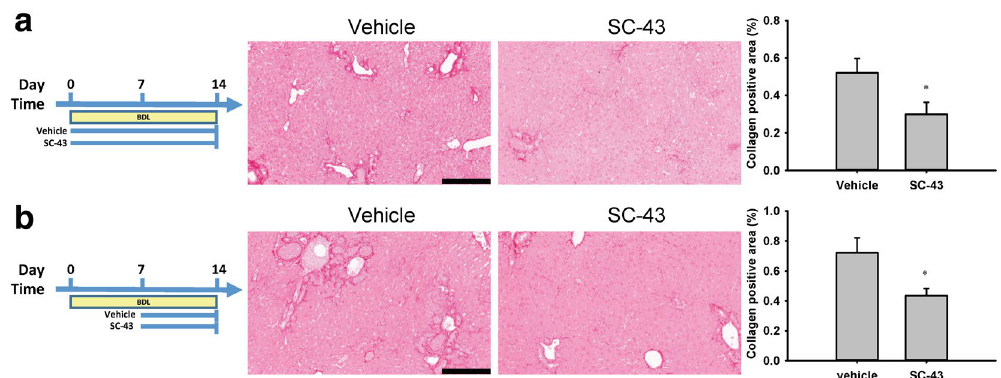
Figure 4. SC-43 treatment ameliorates liver fibrosis in the bile duct ligation liver fibrosis mouse model. In the BDL fibrosis prevention model, the vehicle and SC-43 (10 mg/kg) were administered from day 1 until sacrifice on day 14 of BDL. SC-43 treatment yielded significant fibrosis regression. ( a ) Representative images after sirius red staining and the collagen-positive area quantification. In the BDL fibrosis therapy model, the vehicle and SC-43 (10 mg/kg) were administered since day 8 until sacrifice on day 14 after BDL. The SC-43 treatment yielded significant fibrosis regression. ( b ) Representative images after sirius red staining and the collagen- positive area quantification. Scale bar: 200 μ m. Columns: mean and bars: standard error. * P < 0.05 compared with the vehicle group. N = 7–8 in each